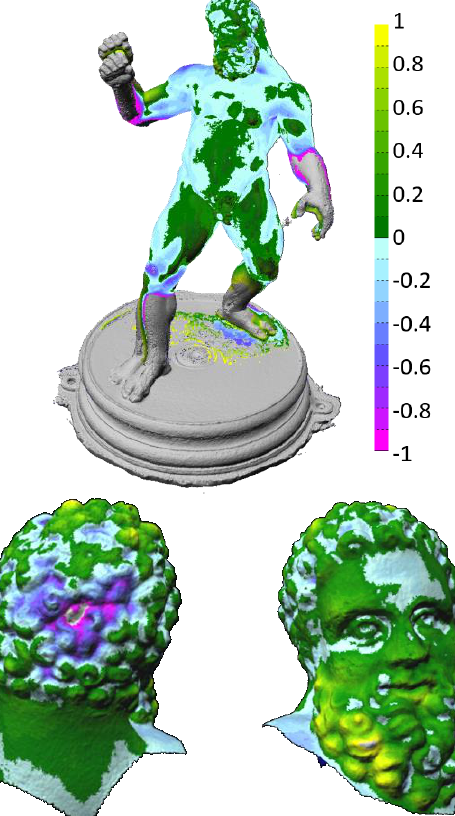
Figure 11. Comparison maps [mm] between the Veleia and Boulogne